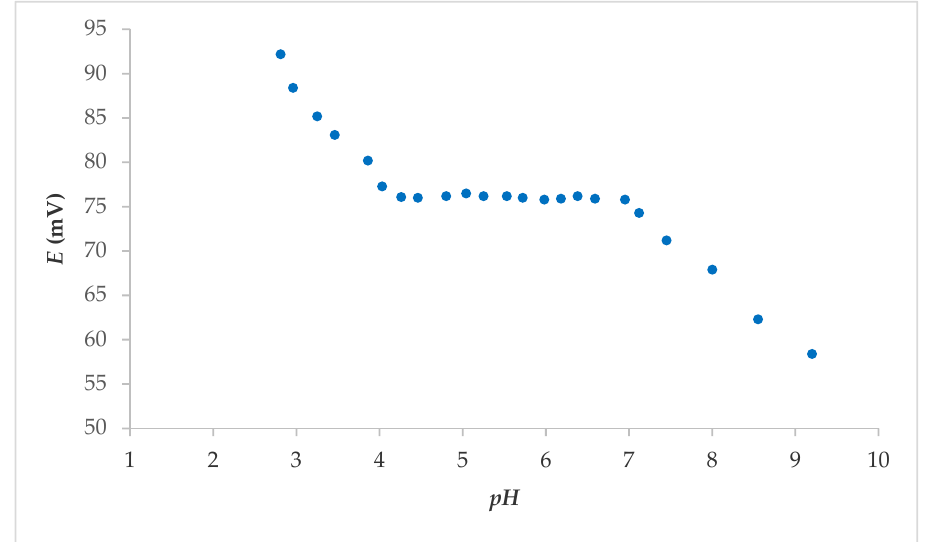
Figure 3. pH effect on the electrode 7S response in F − solution (concentration: 1.00 × 10 − 3 M), after washing Fe x O y NPs from surface.